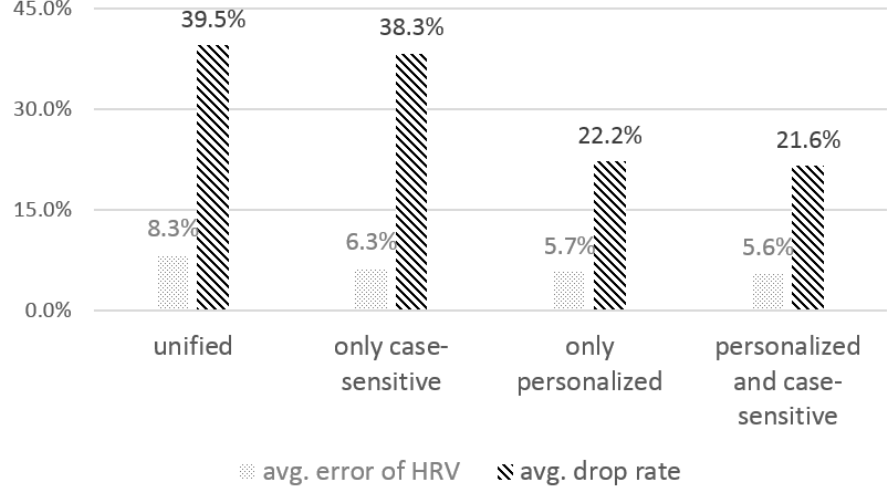
Figure 5. The effect of the personalized and case-sensitive threshold in noise filtering on the average error of the HRV parameters and the average drop rate.